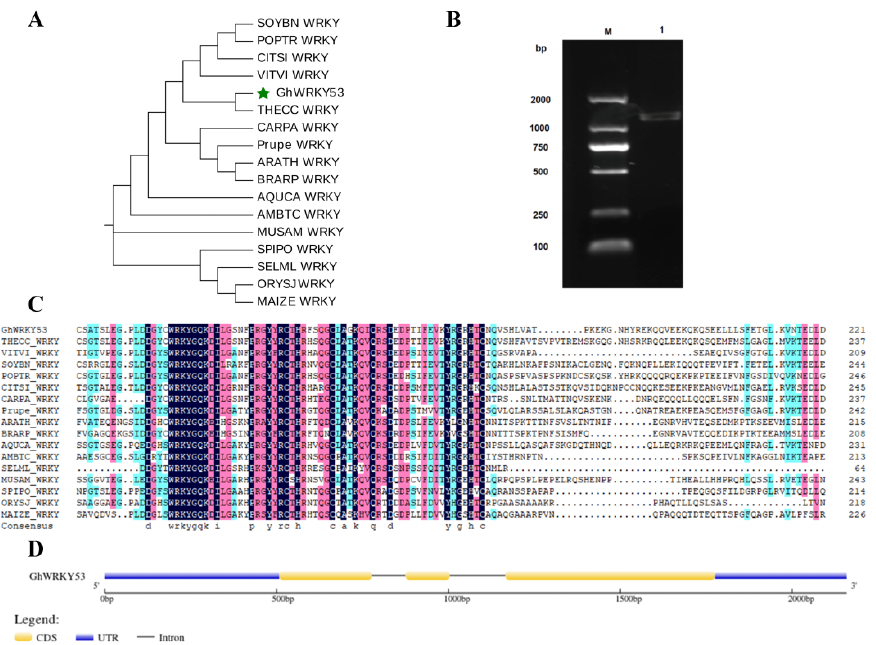
Figure 7. Sequence analysis of GhWRKY53 . ( A ) The phylogenetic was constructed with amino acid sequences of GhWRKY53 and orthologous proteins of GhWRKY53 in several other species (GhWRKKY53 is marked as a green pentagram); ( B ) Clone of GhWRKY53 by RT-PCR. Note: Lane